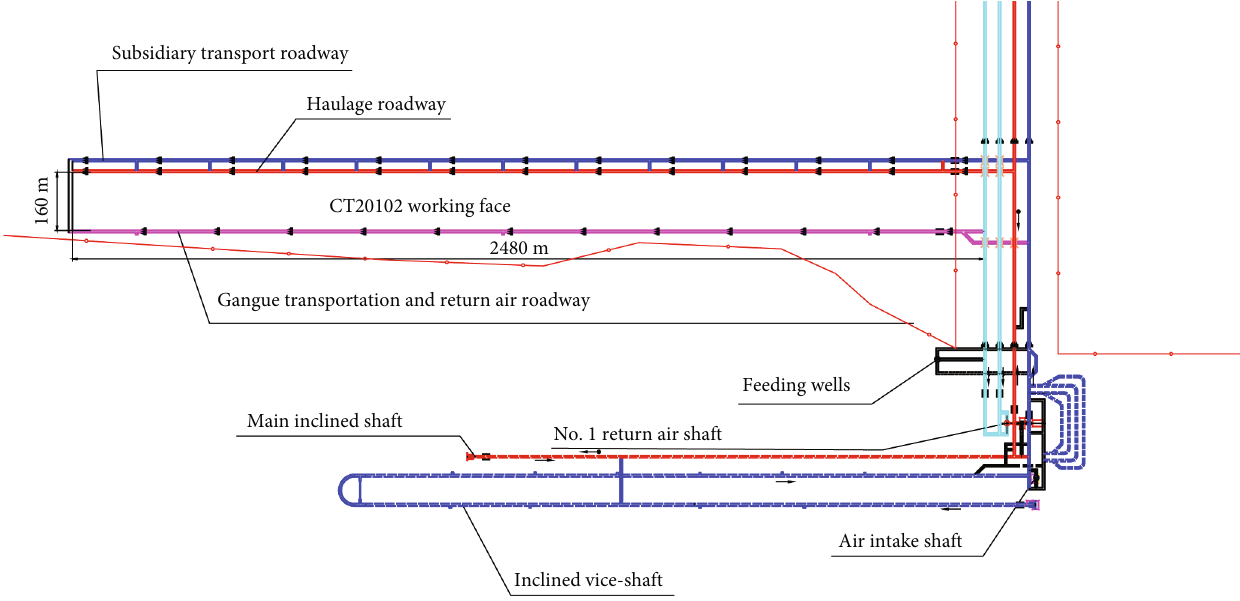
Figure 11: Layout of back fi lling working